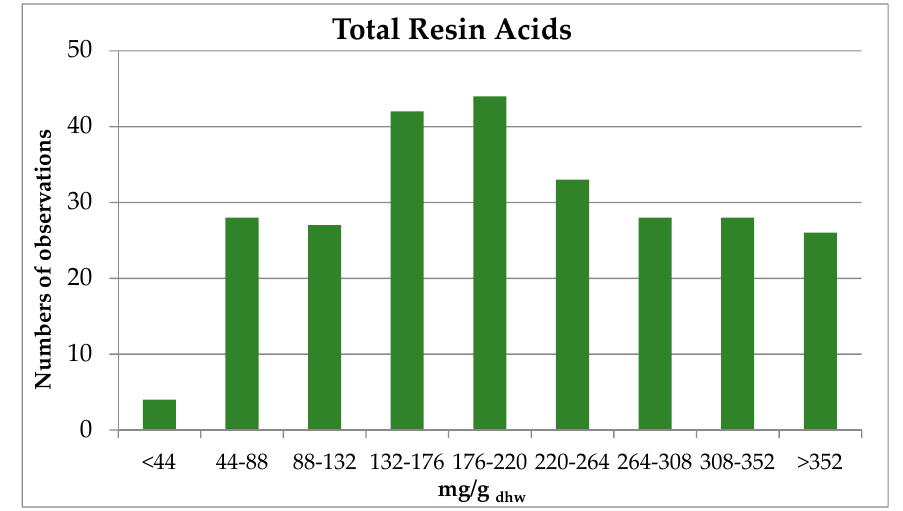
Figure 5. Total resin acids frequency distribution of black pine ( P. nigra Arn.).